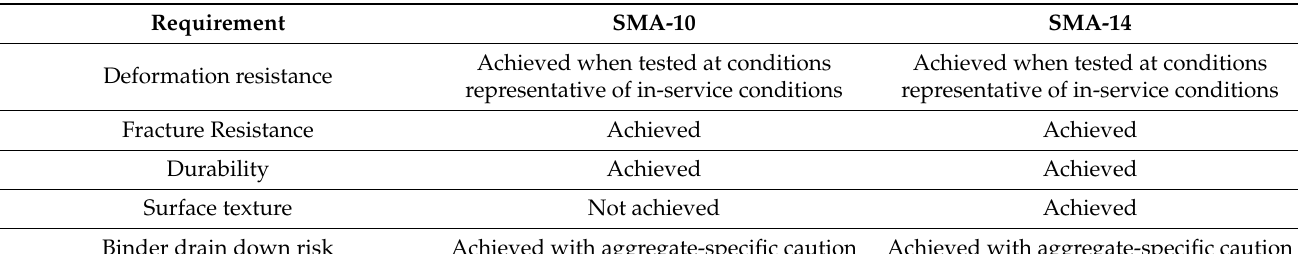
Table 13. Summary of SMA performance compared to airport